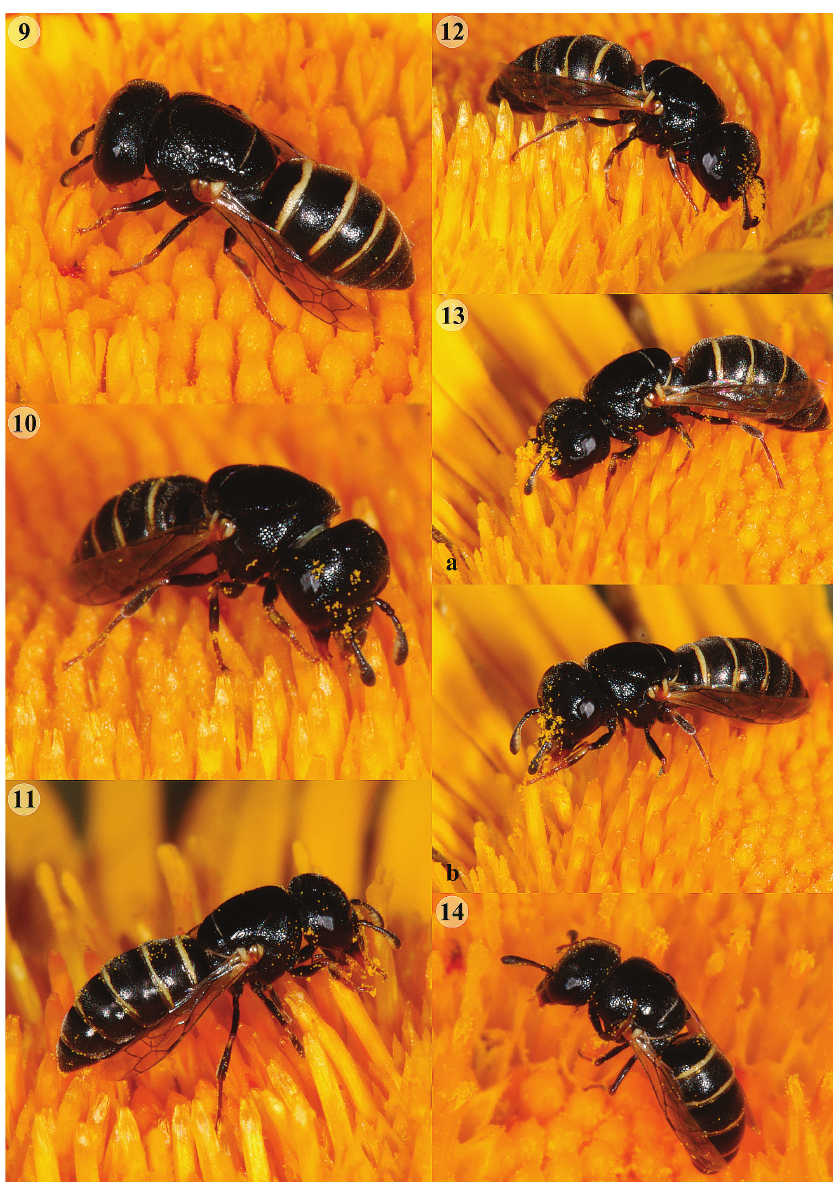
Figures 9–14. Flower visiting behaviour of females of Quartinia major . 9 Nectar uptake from disc flo- rets on capitulum of Asteriscus graveolens 10 Female with protruded proboscis taking up nectar from disc florets of Pulicaria mauritanica 11 Ingestion with the mouthparts of pollen grains that had accumulated on the fore legs 12 Female pressing pollen out of the corolla tube of a disc floret of P. mauritanica with her mouthparts, while the pollen grains accumulate above the corolla in front of her head surrounded by her antennae 13 Pollen uptake from disc floret of P. mauritanica a Female pressing pollen out of the corolla tube b female immediately afterwards ingesting pollen supported by her fore legs 14 Female brushing pollen from her exoskeleton with rapid alternating movements of her fore